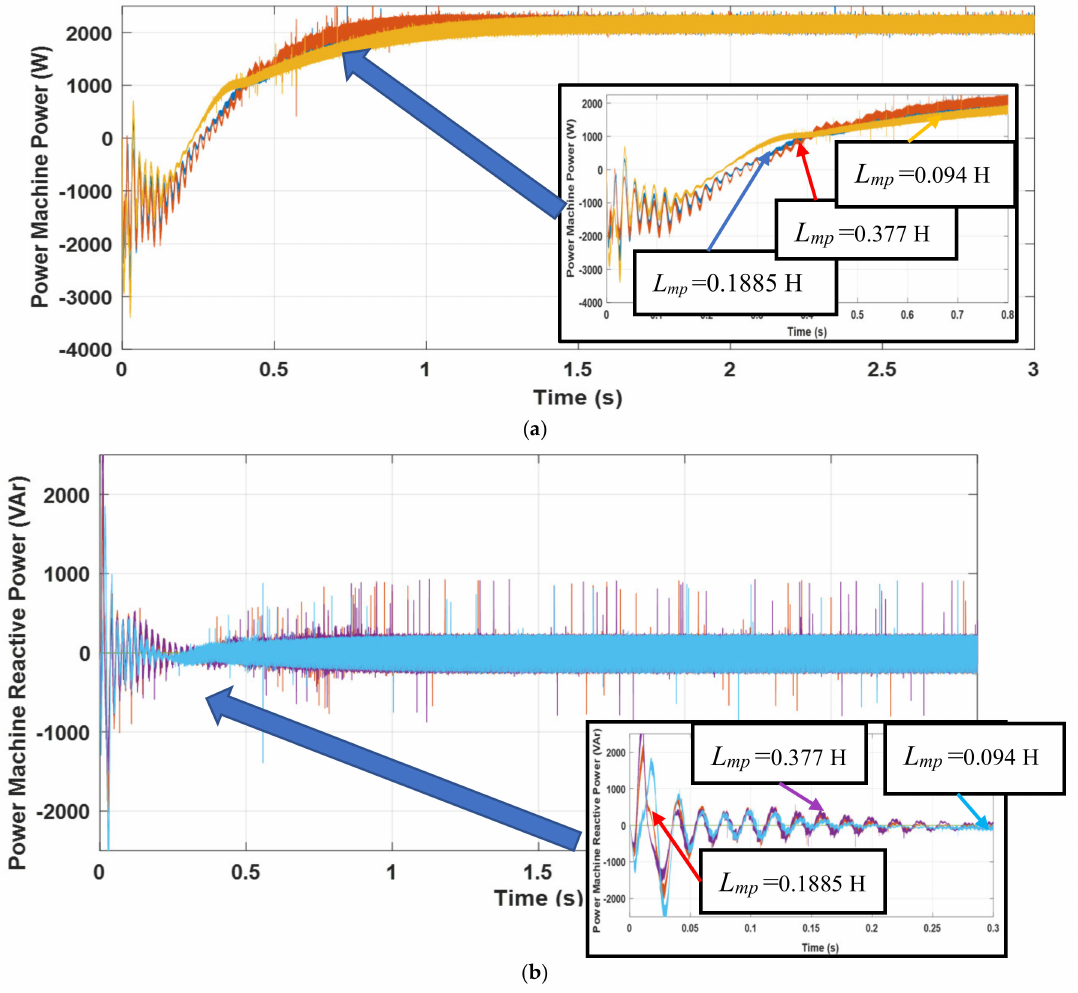
Figure A5. Machine-side converter (MSC) waveforms at varying power machine (PM) mutual inductance: ( a ) grid injected power, ( b ) grid injected reactive